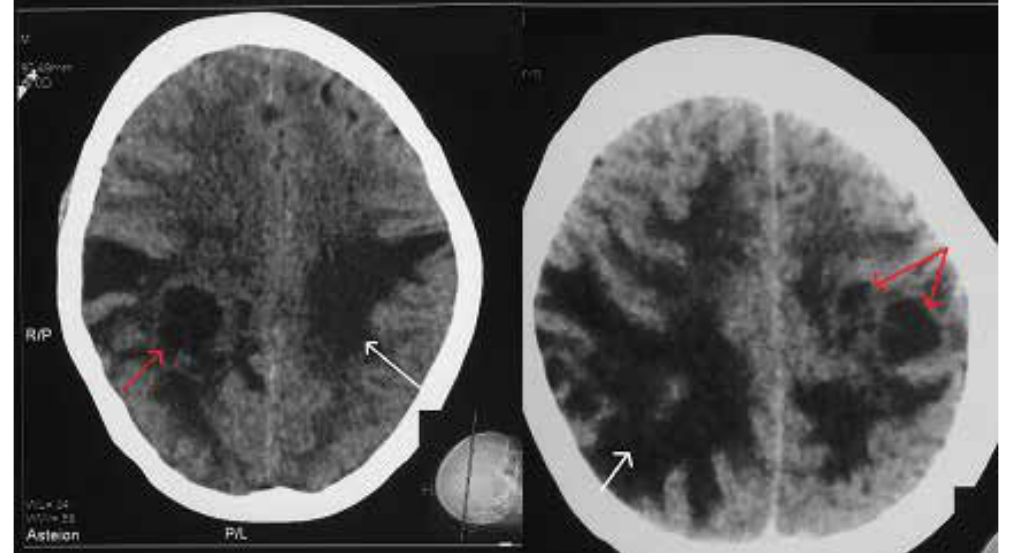
Fig 1. Plain CT scan of brain showing multiple abscesses (red arrows) with marked disproportionate periabscess edema (white arrows) in bilateral parietal